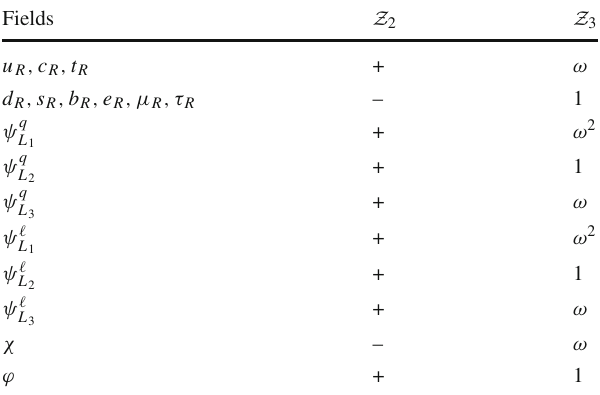
Table1 Thechargesofleftandright-handedfermionsofthreefamilies of the SM, Higgs and the flavon field under the Z 2 and Z 3 product symmetry, where ω is the cube root of unity Fields Z